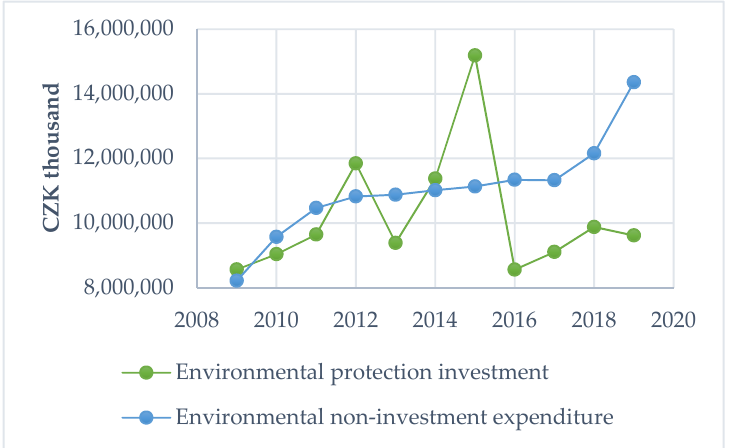
Figure 6. Environmental protection investment and non ‐ investment expenditure on wastewater management in the Czech Republic during 2009–2019.